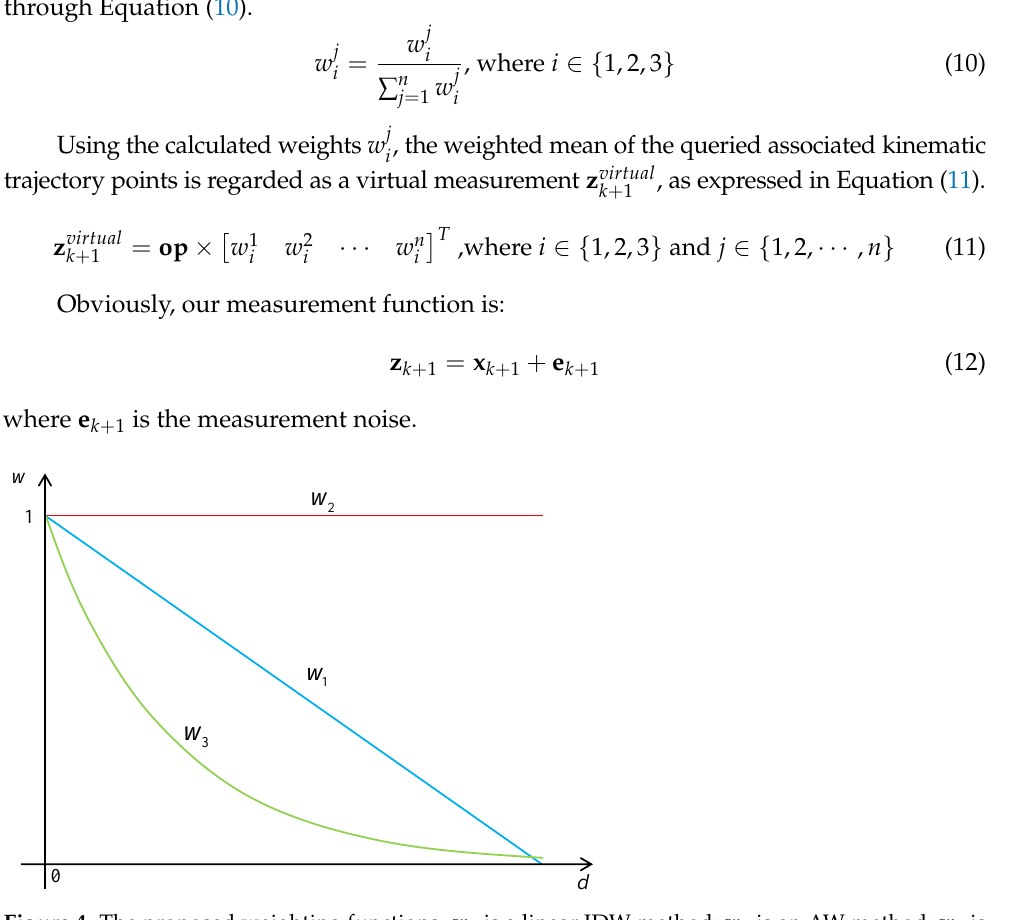
Figure 4. The proposed weighting functions. w 1 is a linear IDW method; w 2 is an AW method; w 3 is a nonlinear IDW